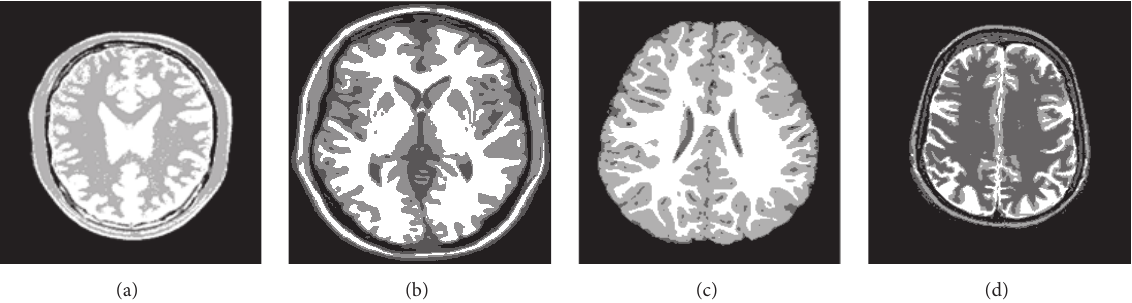
Figure 4: Segmentation results obtained by Otsu.